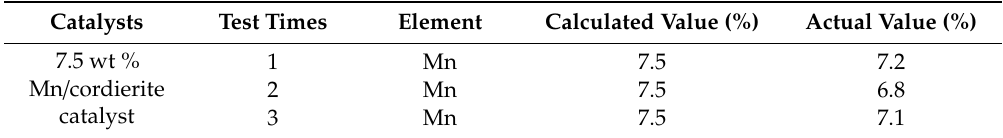
Table 2. Elemental analysis results for the catalysts.